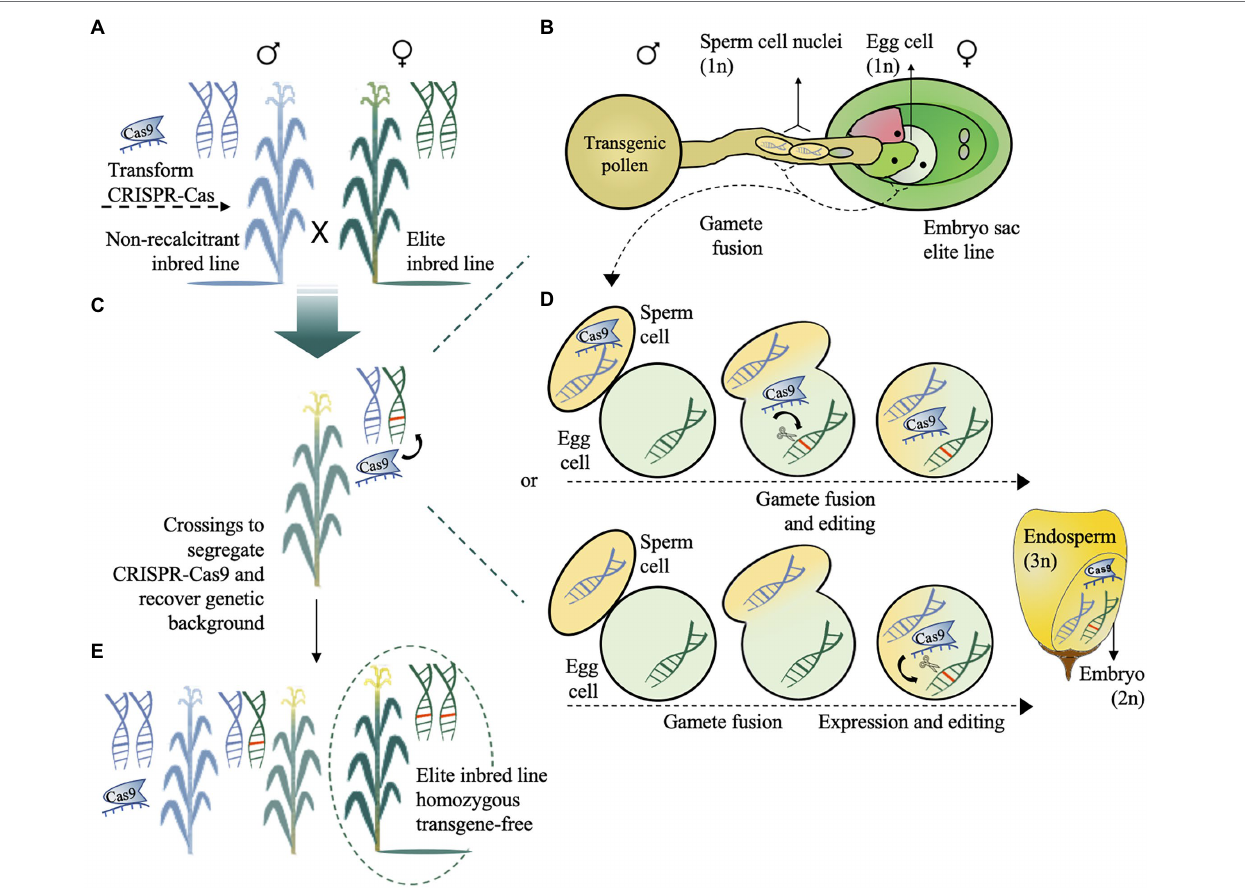
FIGURE 3 | Schematic representation of the desired-target mutator (DTM) maize transformation. (A) The CRISPR-Cas cassette can be transformed into a nonrecalcitrant inbred line for trans editing in an elite recalcitrant inbred line. (B) Pollen carrying a CRISPR-Cas cassette designed to target gene(s) of interest was used to pollinate the elite maize line. (C) The target gene is directly edited via trans-acting CRISPR-Cas. (D) The delivery of RNP, which is expressed by the sperm cell, directly into the egg cell of the elite line (gametophytic expression) or expression of RNP in the zygote after gamete fusion (zygotic expression) generates a hybrid edited embryo. (E) After trans editing, subsequent crossings are needed to obtain CRISPR-Cas-free plants with the original receptor genetic background and homozygous to the desired mutation. The schematic illustration view in (D) was adapted from Jacquier et al.